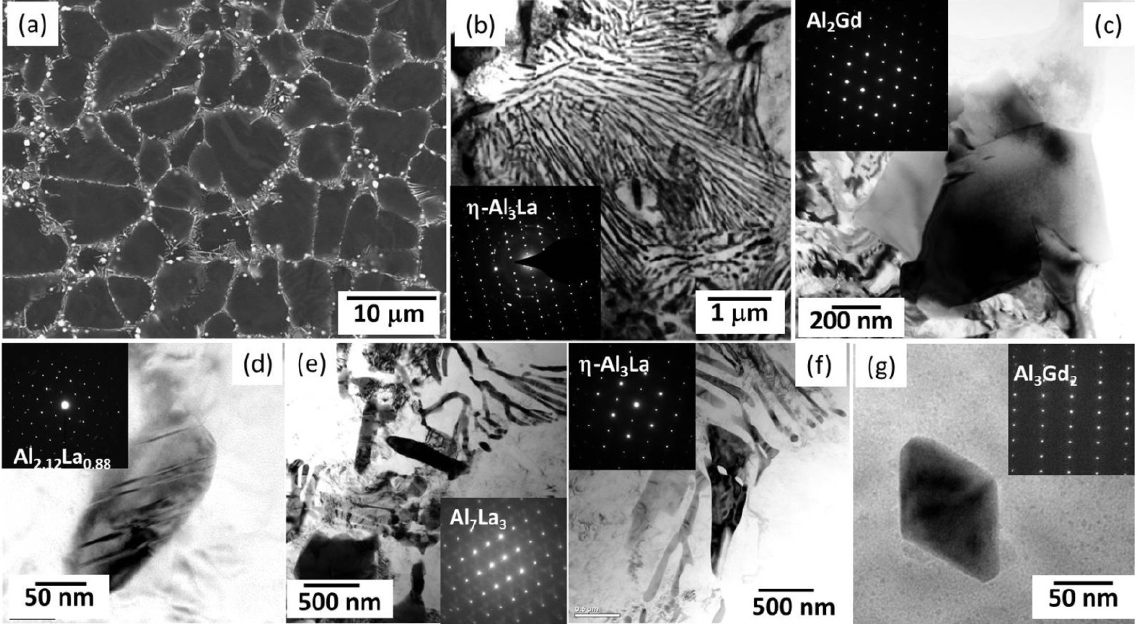
Figure 10. ( a ) SEM image of ALaGd432 alloy and ( b – g )TEM images along with the corresponding SAED paerns (the inserts) of the intermetallic phases